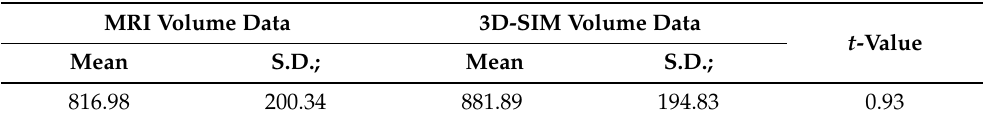
Table 8. Paired samples of breast volume data (unit = cm 3 ).